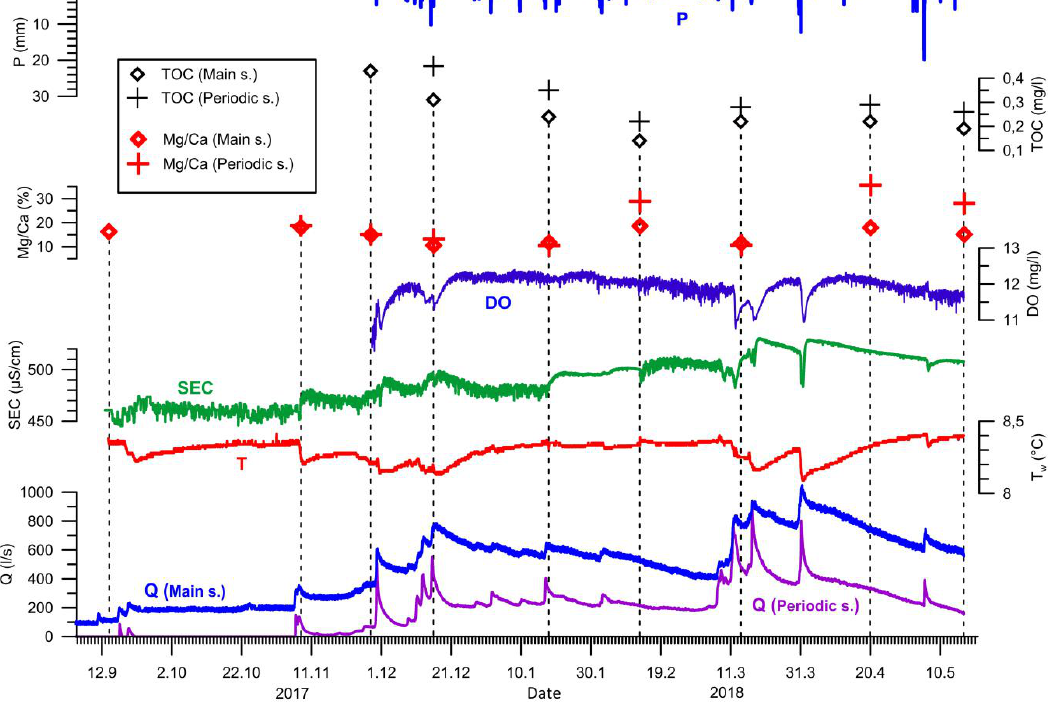
Figure 3. Discharge (Q), total organic carbon content (TOC), Mg/Ca molar ratio, and precipitation (P) data for both Krbavica springs; temperature (T), specific electrical conductivity (SEC) and dissolved oxygen (DO) data monitored in the main spring.